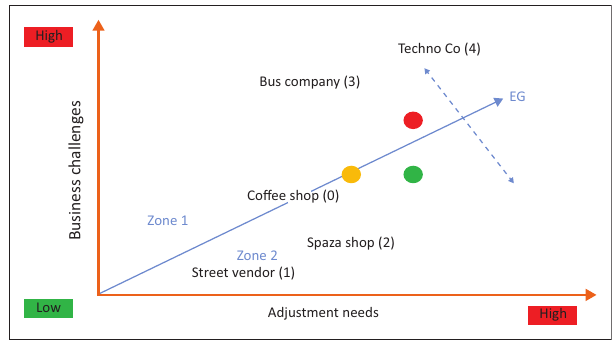
FIG URE 4: Entrepreneurship gap